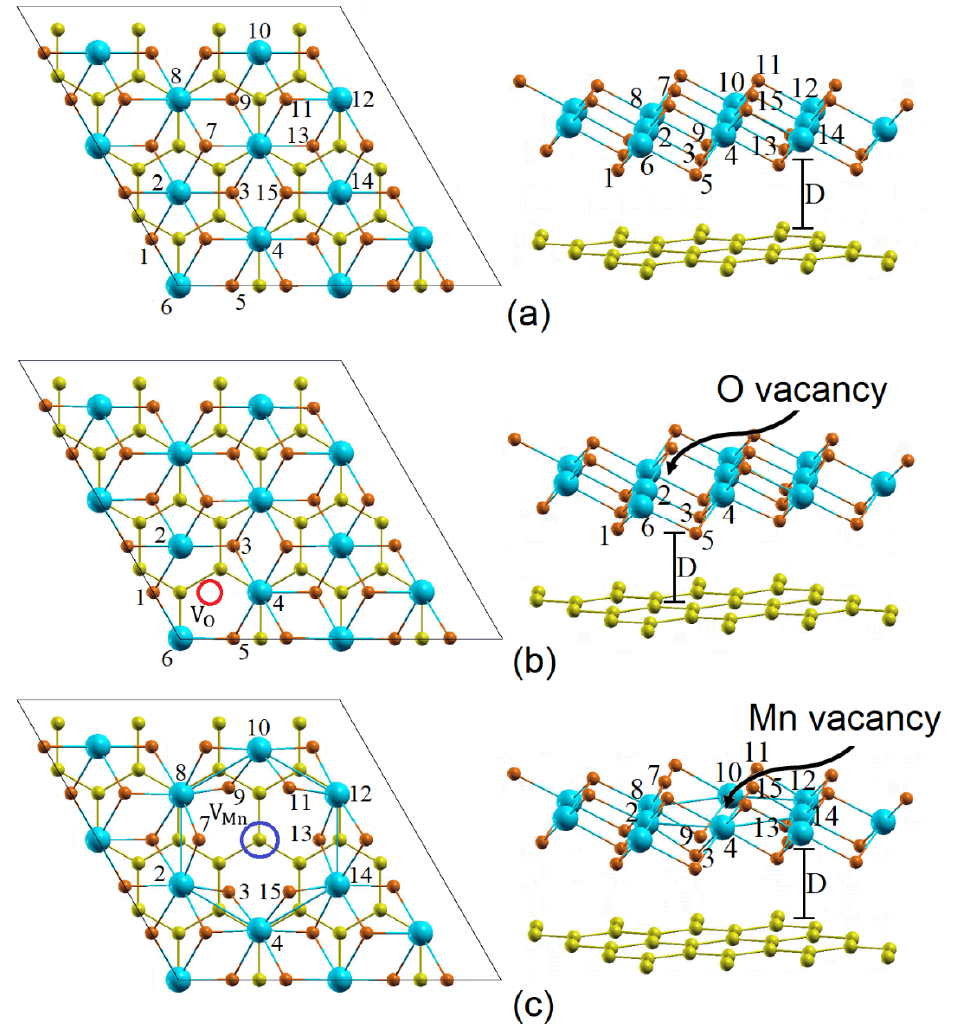
√ √ − y (2 3 × 2 3)/graphene (4 × 4) interface. ( a ) Pure 2